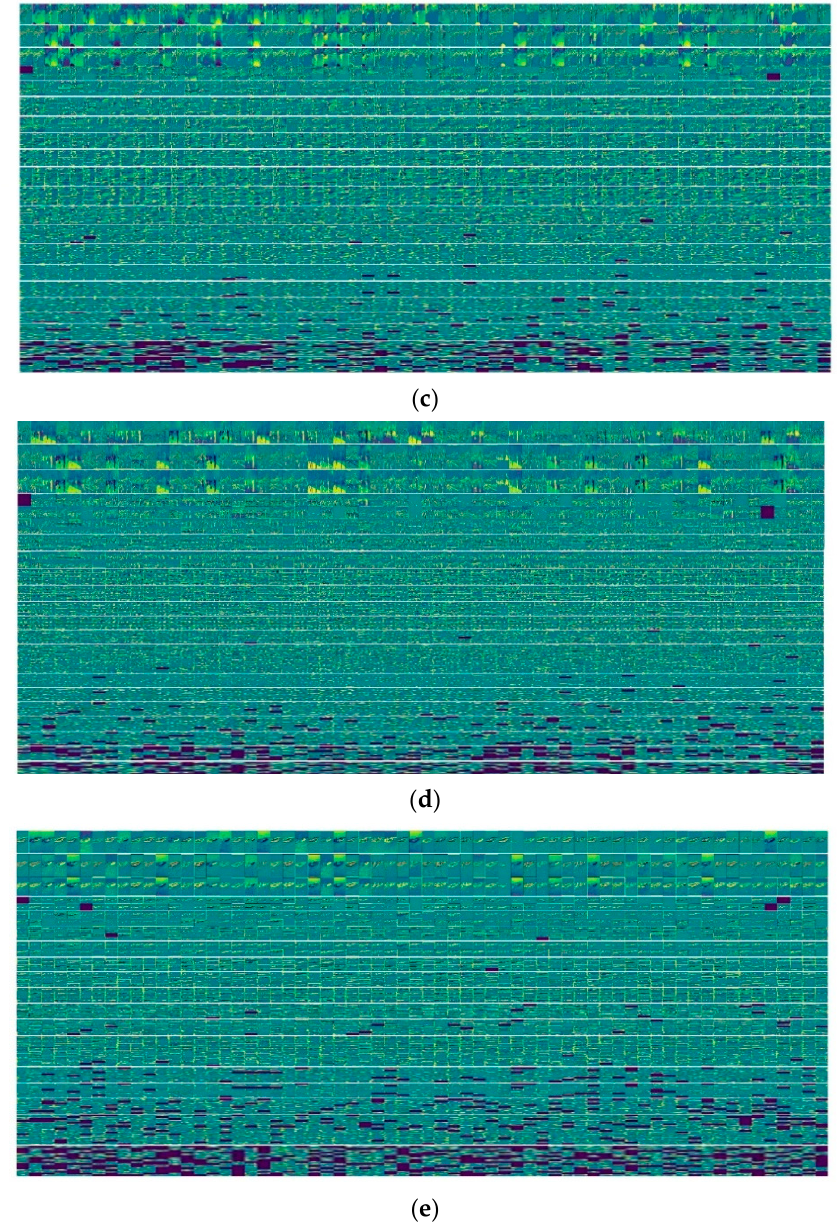
Figure 8. The feature maps produced by the convolutional part of Model 9 of ( a ) Boli Khela, ( b ) Kabaddi, ( c ) Kho Kho, ( d ) Lathi Khela, and ( e ) Nouka Baich.